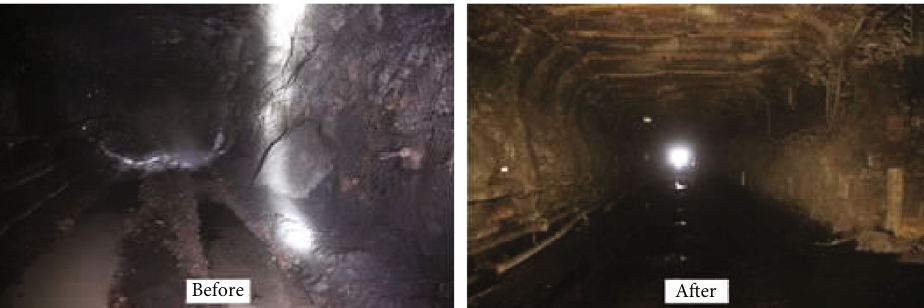
Before After Figure 19: E ff ect picture of entry staying along goaf before and after roof failure pressure